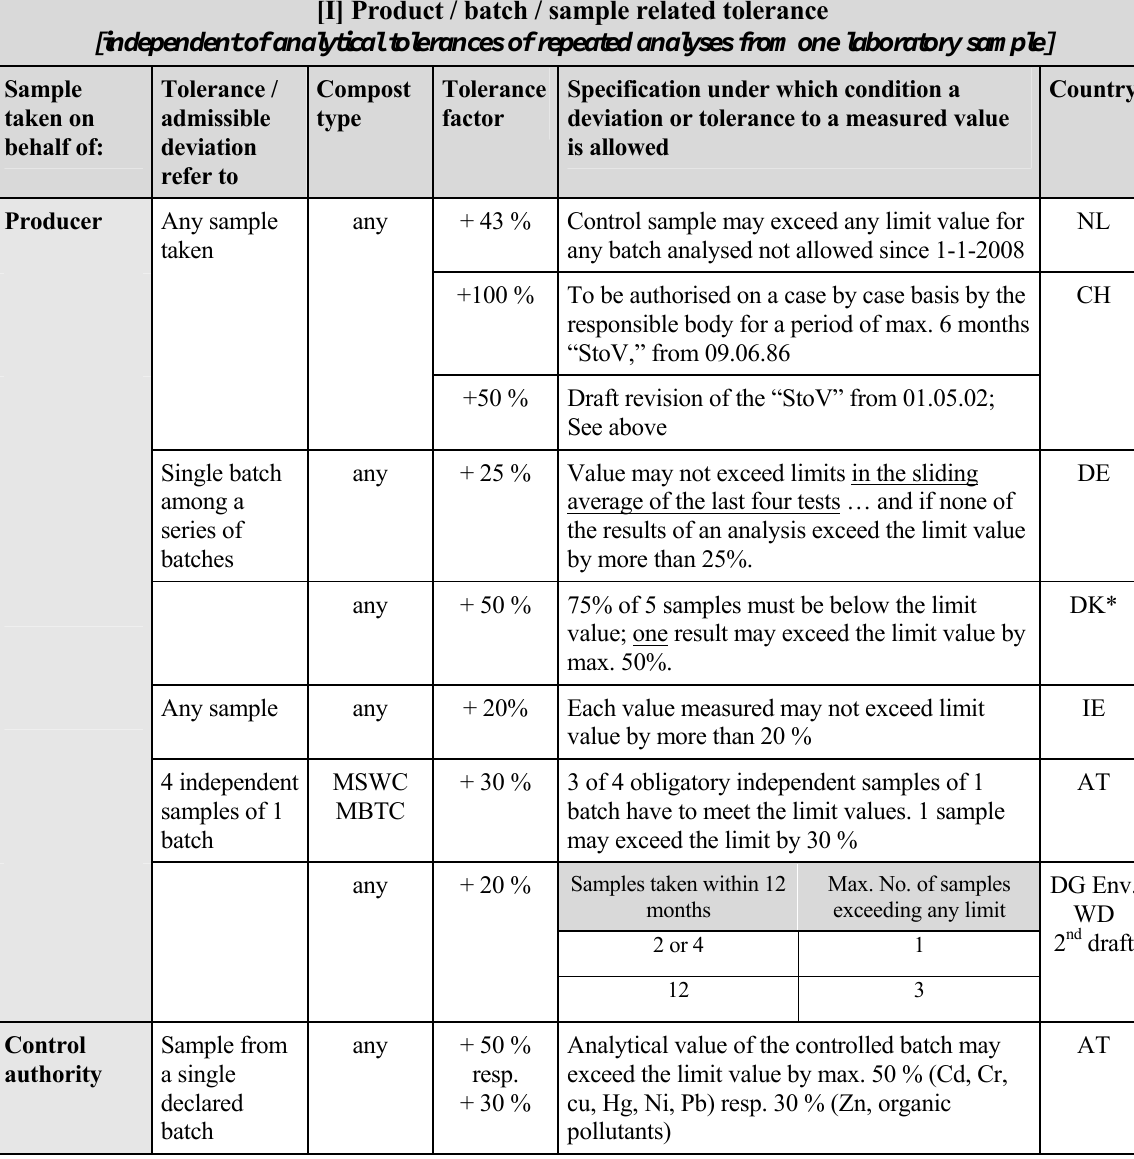
Table 13: Systems of tolerated deviations of limit values for composts [I] Product / batch / sample related tolerance [independent of analytical tolerances of repeated analyses from one laboratory